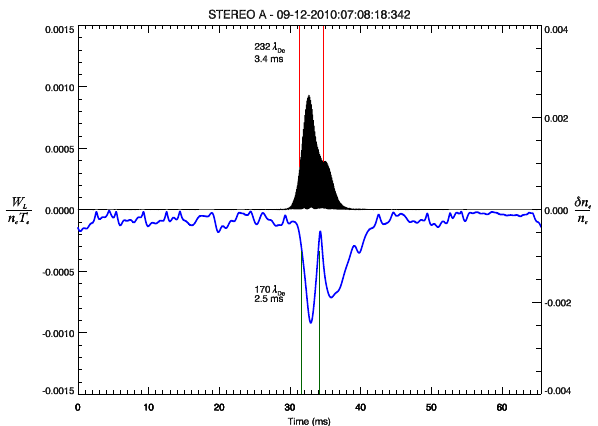
Fig. 5. The simultaneous observations of the collapsing Langmuir wave packet plotted in terms of normalized energy density, W L (t) and the density fluctuations, δn e (t)